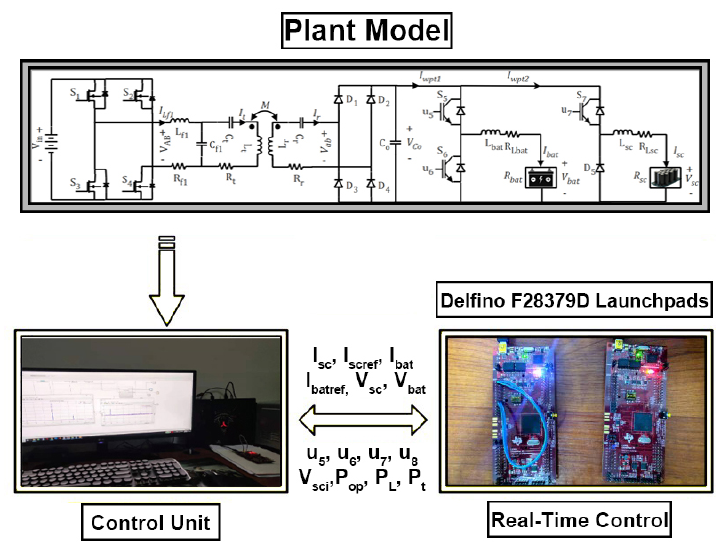
Figure 17. Configuration of the controller hardware in loop